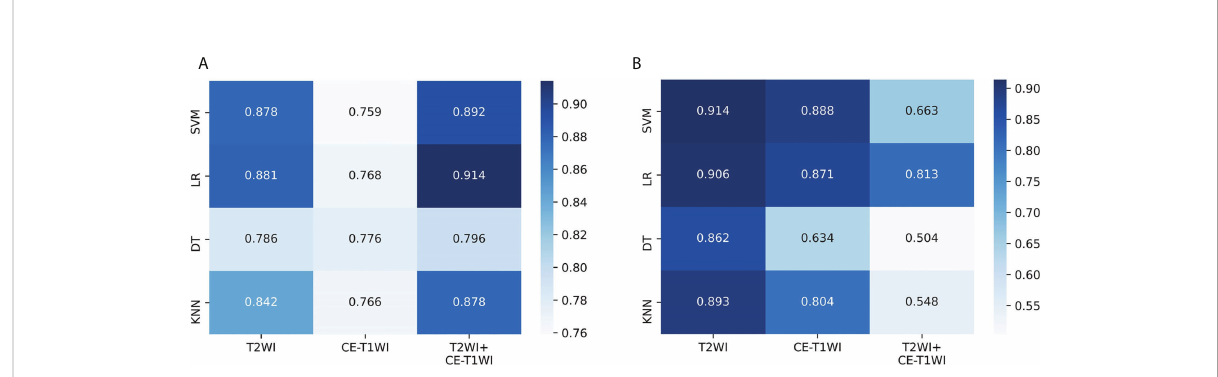
FIGURE 5 Performance of twelve machine learning models on the two test sets. (A) The AUC values in the test set 1. (B) The AUC values in the test set 2. SVM, support vector machine; LR, logistic regression; DT, decision tree; KNN, k-nearest neighbor; T2WI, T2-weighted image; CE-T1WI, contrast – enhanced T1-weighted image; T2WI+CE-T1WI, the combination of T2-weighted image and contrast – enhanced T1-weighted